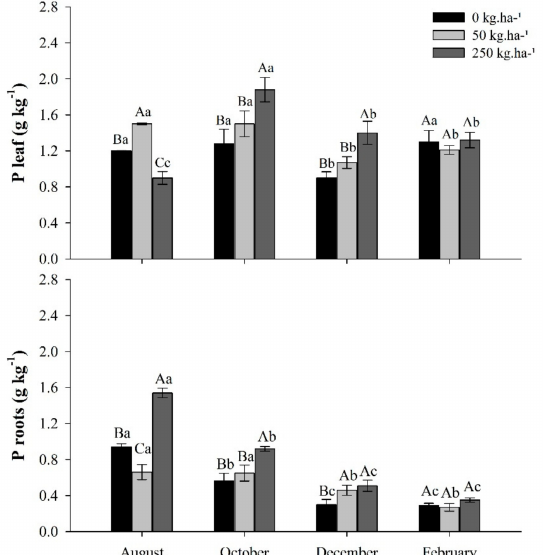
Figure 1. Phosphorus (P) content in leaves and roots of C. guianensis plants fertilized with phosphorus at different collection periods. Means followed by distinct letters differ from each other ( p < 0.05), where uppercase letters represent the differences between treatments and lowercase letters between the evaluation periods.